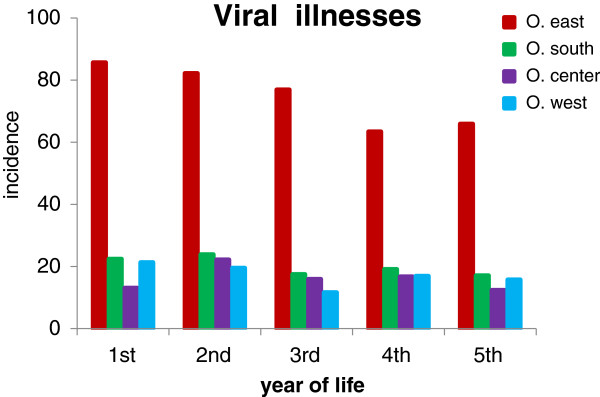
Incidence of viral illnesses per 100 children per year of life. The vast majority of diagnoses in O. east were infections of unspecified site (ICD code B34). Numbers of children stratified by age and region of residence are presented in Table 3.